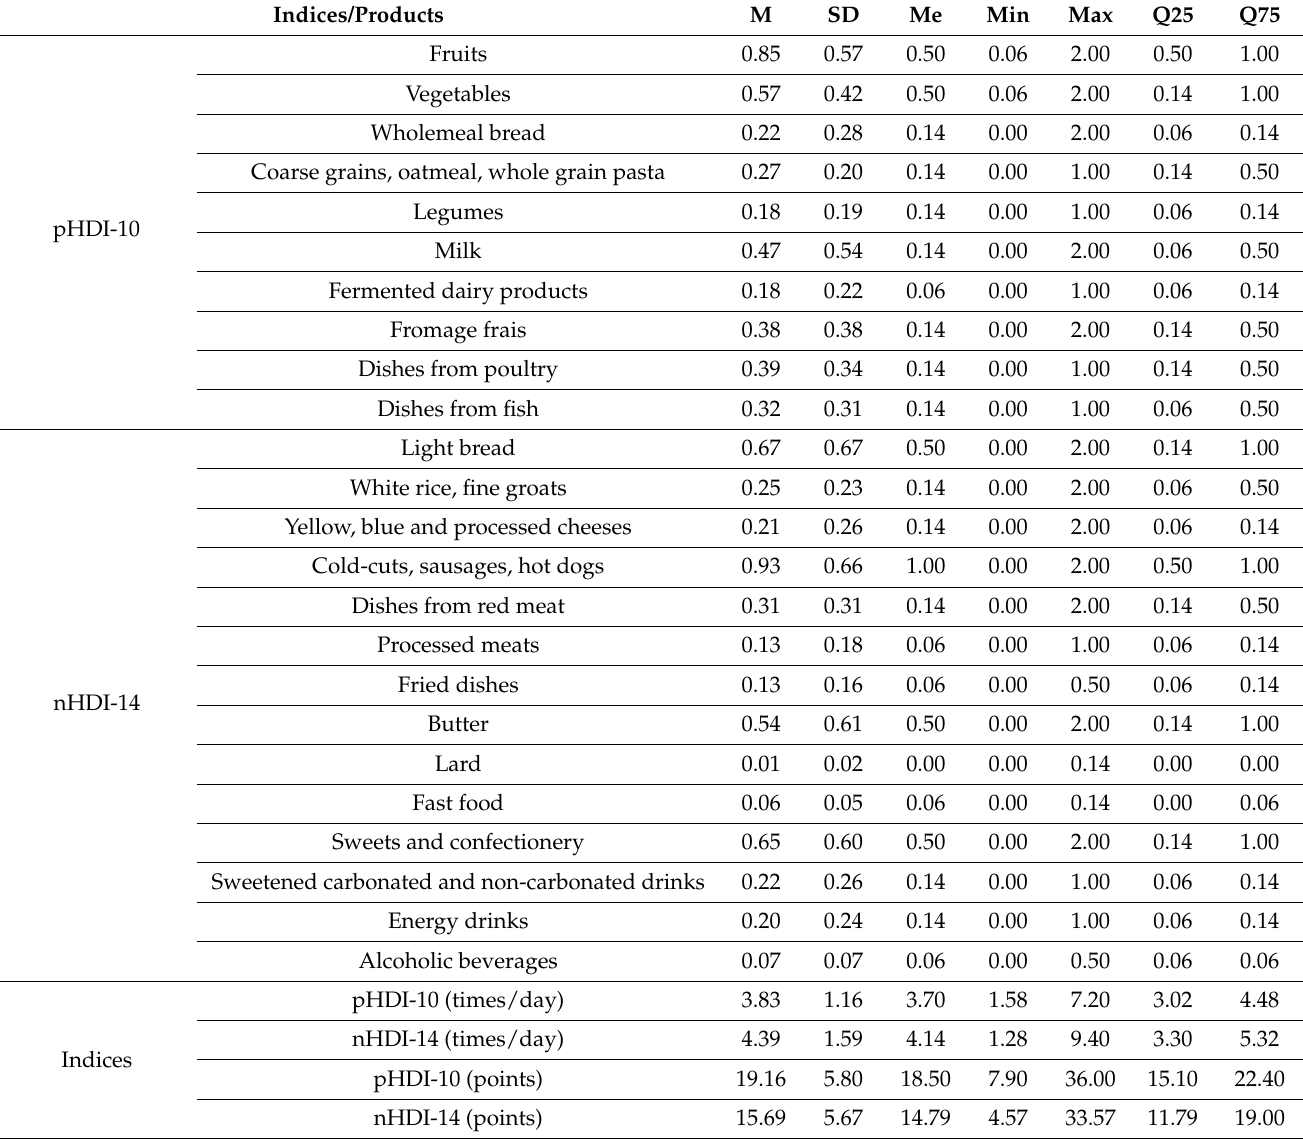
Table 2. Daily frequency of consuming products with potentially beneficial and potentially detrimental impact on health and value of pro-healthy (pHDI-10) and non-healthy (nHDI-14) diet indices (N = 213) among the studied athletes (N = 213) (descriptive